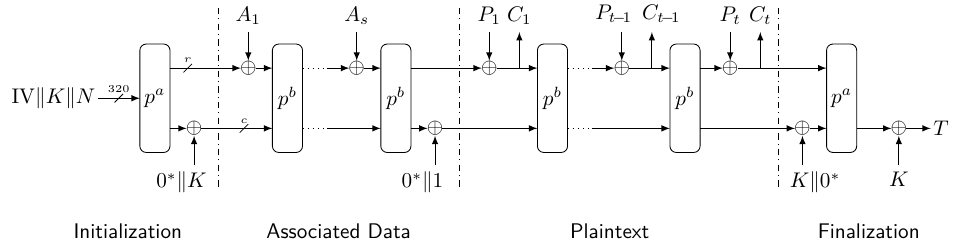
Figure 1: Ascon ’s mode of operation (encryption phase)